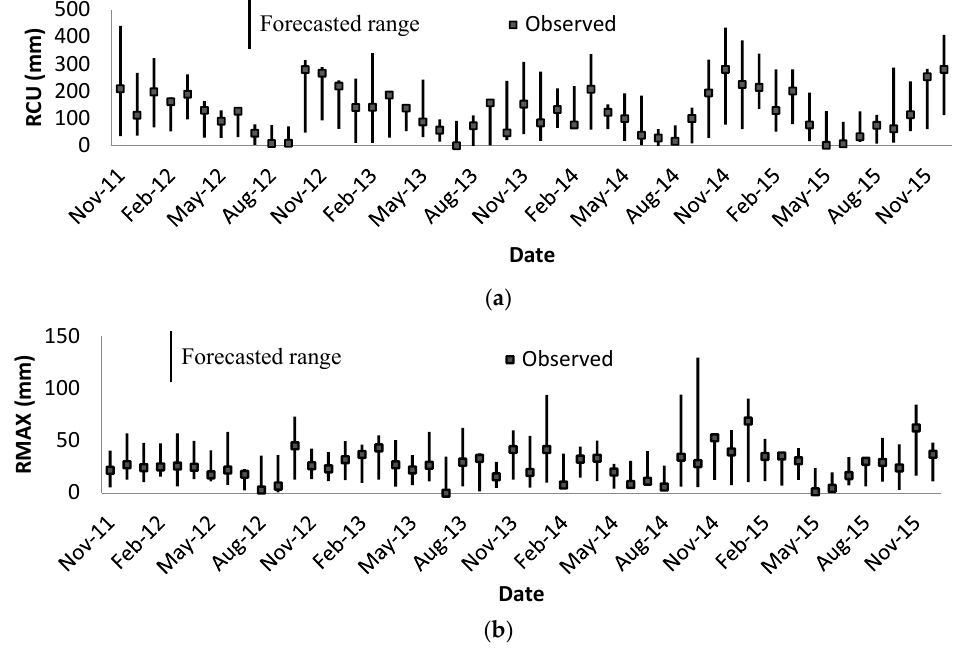
Figure 7. Forecasted range of variation by TOPSIS for ( a ) RCU and ( b ) RMAX. Results show that 48 out of 50 events for RCU and 46 out of 50 events for RMAX fall in the